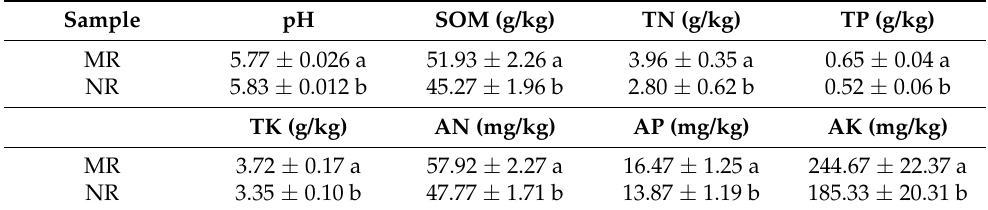
Table 2. The chemical properties of different soil samples. Sample pH SOM